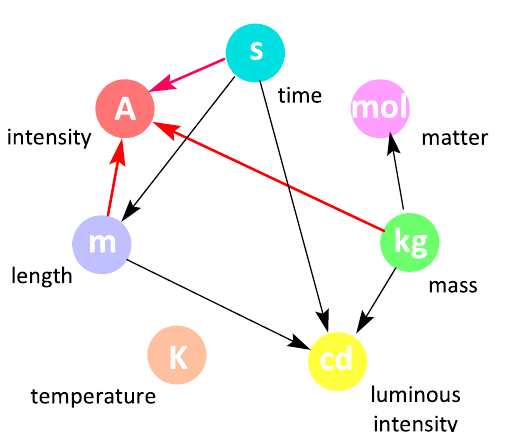
Fig. 4. Former relationships between SI units.